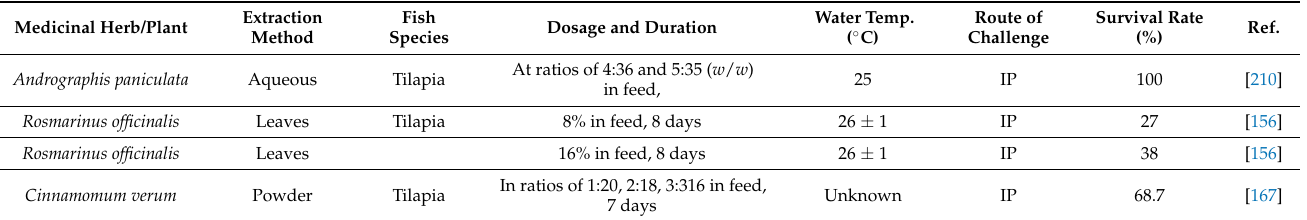
Table 4. In vivo disease resistance of medicinal/plants towards S. agalactiae infection. IP= intraperi- toneal injection; IM = intramuscular